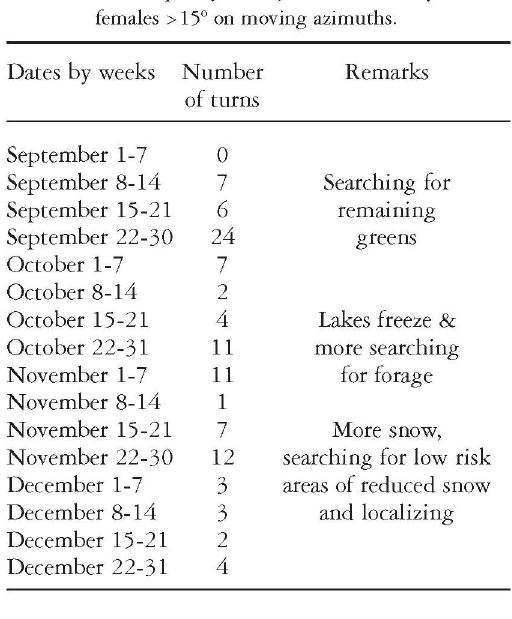
Table 6. The frequency of major turns made by satellite females >15° on moving